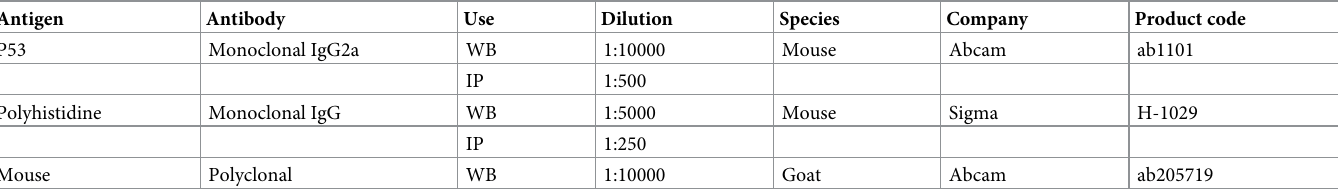
Table 1. Antibodies used in the